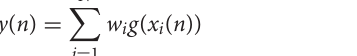
τ i (blue tick marks) during the last of those k { }